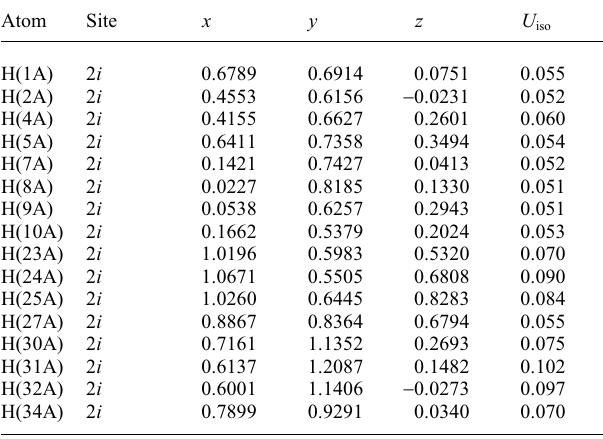
Table 2. Atomic coordinates and displacement parameters (in Å 2 )